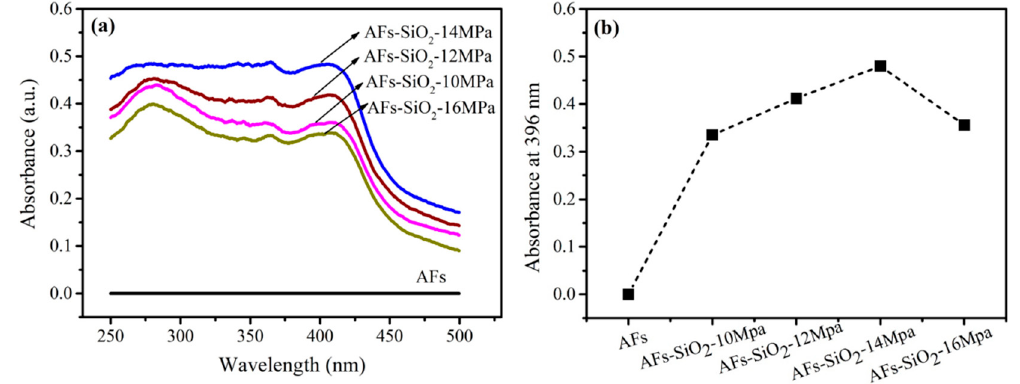
Figure 8. UV–Vis spectra of untreated and SiO 2 -treated AFs ( a ) and their absorbances at 396 nm ( b ).